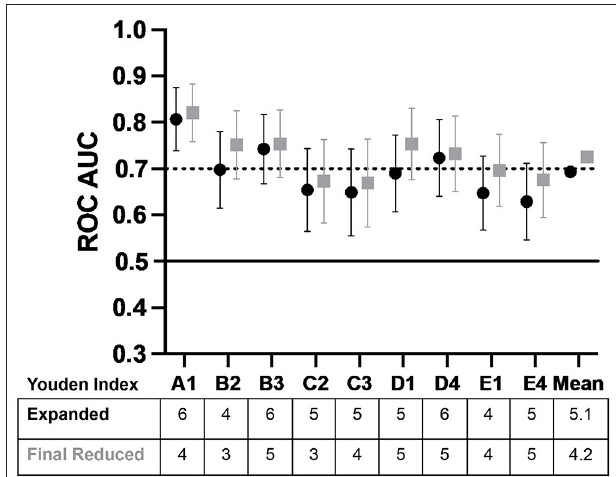
FIGURE 6 | The average ROC AUC values plotted across the study showing the potential for a matured epithelial cell and immune cell, Gram-positive diplococci, and Gram-negative rod reduced scoring system. Both the final expanded and reduced systems offer acceptable predictability, however, the reduced scoring system offers a slightly higher ROC AUC ( ± 95% CI ). The final reduced system is simplified, scoring the most easily recognized cells and morphotypes in the current set of Gram stains supporting its utility in future work (AUC is interpreted as follows: 0.5 AUC, no predictive ability; 0.7– < 0.8, acceptable predictive ability; 0.8– < 0.9, excellent predictive ability). The black circles indicate final expanded scoring system which included Gram-positive cocci, Gram-positive rods, Gram-positive diplococci, Gram-negative cocci, Gram-negative rods, inflammatory cells, and mature epithelial cells. The gray squares indicate the final reduced scoring system which included Gram-positive diplococci, Gram-negative rods, inflammatory cells, and mature epithelial cells. The Youden Index, which is the cut-off above which is considered inflammation, is shown in the table under the graph, with indicators of subsample and operator (e.g., A1 is subsample A graded by Operator